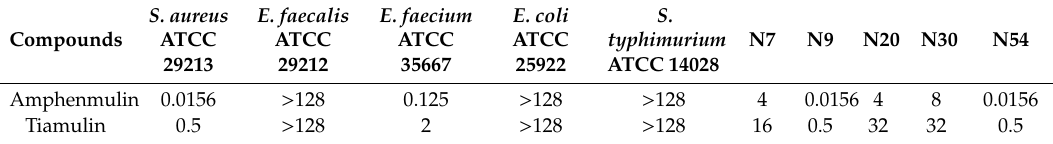
Table 1. MIC (µg/mL) for S. aureus ATCC 29213, E. coli ATCC 25922, S. typhimurium ATCC 14028, E. faecalis ATCC 29212, E. faecium ATCC 35667, and five clinical strains of MRSA (N7, N9, N20, N30, and N54).